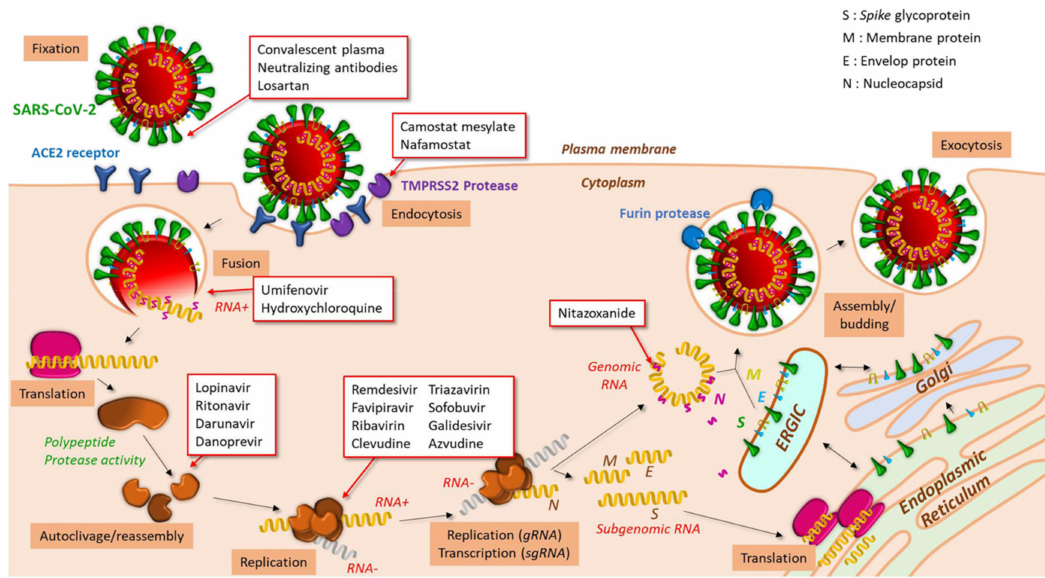
Figure 3. Mechanisms of action of the antiviral drugs on the viral life